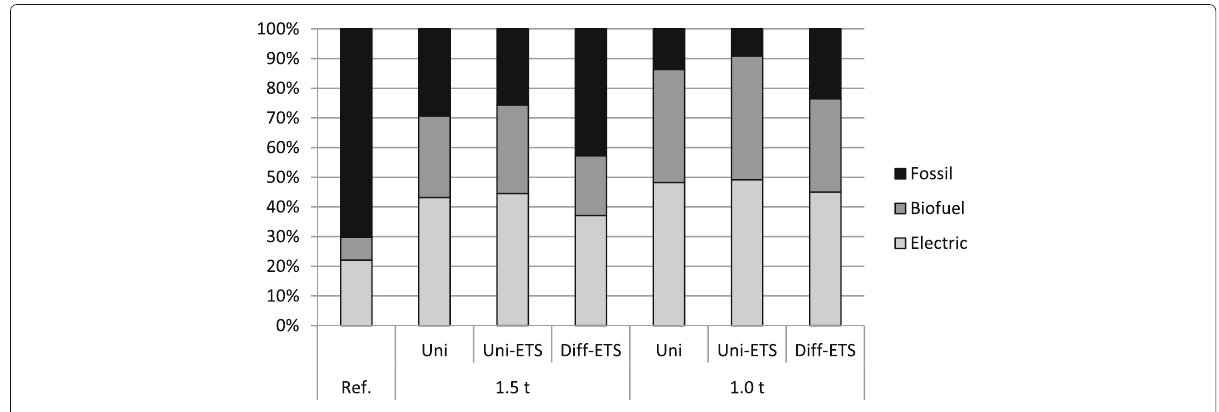
Fig. 3 Share of each vehicle type in distance travelled in percentage in 2050—cars